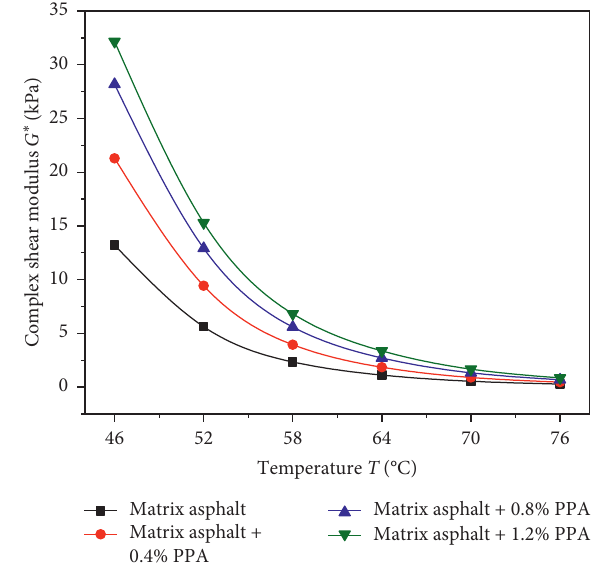
Figure 3: Effect of PPA content on the complex shear modulus G ∗ of PPA-modified